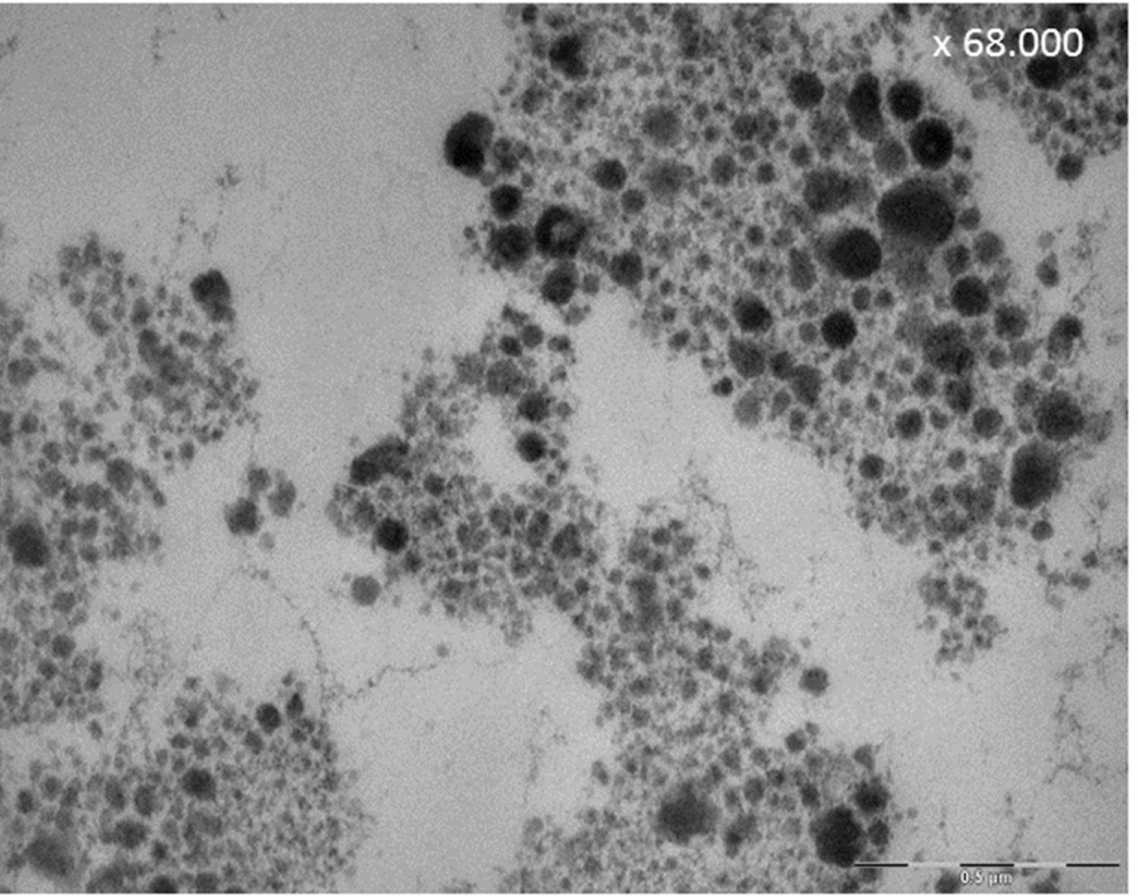
Figure 9. Effect of polyphenols on salivary proteins: Representative TEM-image of a saliva-sample after 30-s in vivo rinsing with 5% tannic acid, pH 2.0. The rinsing of tannic acid leads to aggregation of polyphenolic compounds with salivary proteins visible as electron dense